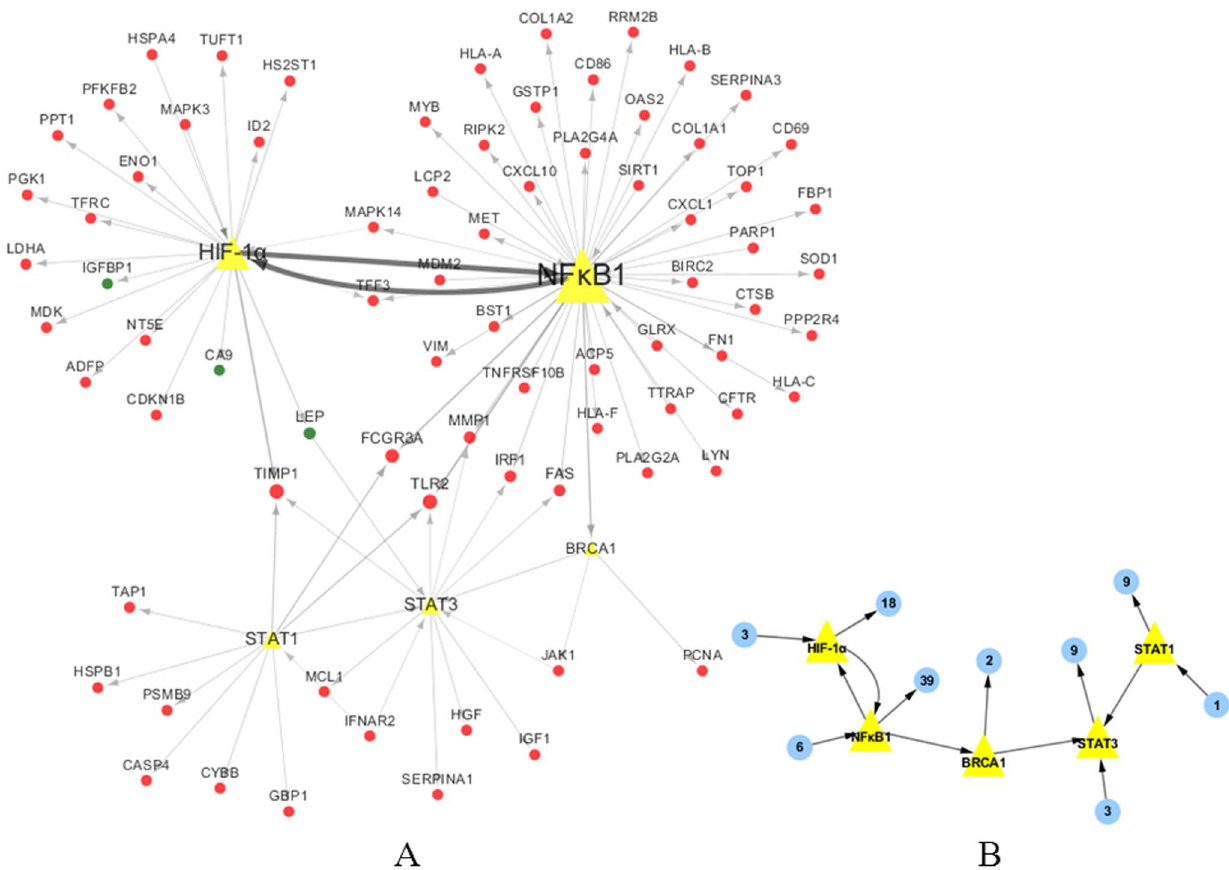
Figure 3. TF-gene network of these 82 differentially expressed genes in gastric cancer tissues. Red circles in A are up-regulated genes, whereas green circles are down-regulated genes and the yellow triangles are these five key TFs. B, The brief framework of this network. The circles are the clustered genes and the number of genes is shown inside. The direction of the arrow is from the Source to the Target.